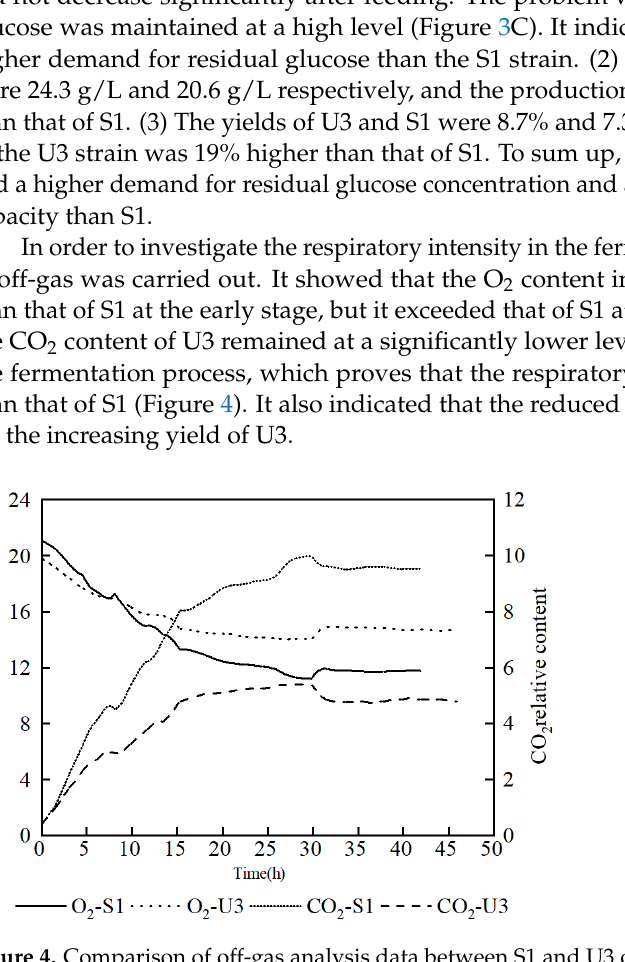
Figure 3. Fed-batch fermentation by strains S1 and U3 in a 7.5-L bioreactor containing 3 L of fer- mentation medium. ( A ) time course pro fi le of cell growth; ( B ) ribo fl avin production during fermen- tation; ( C ) concentration of residual glucose.